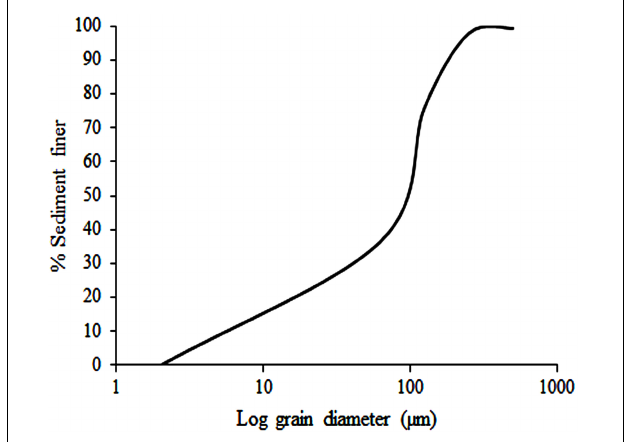
FIGURE 5 | Cumulative curve of sediment grain size of Kuakata